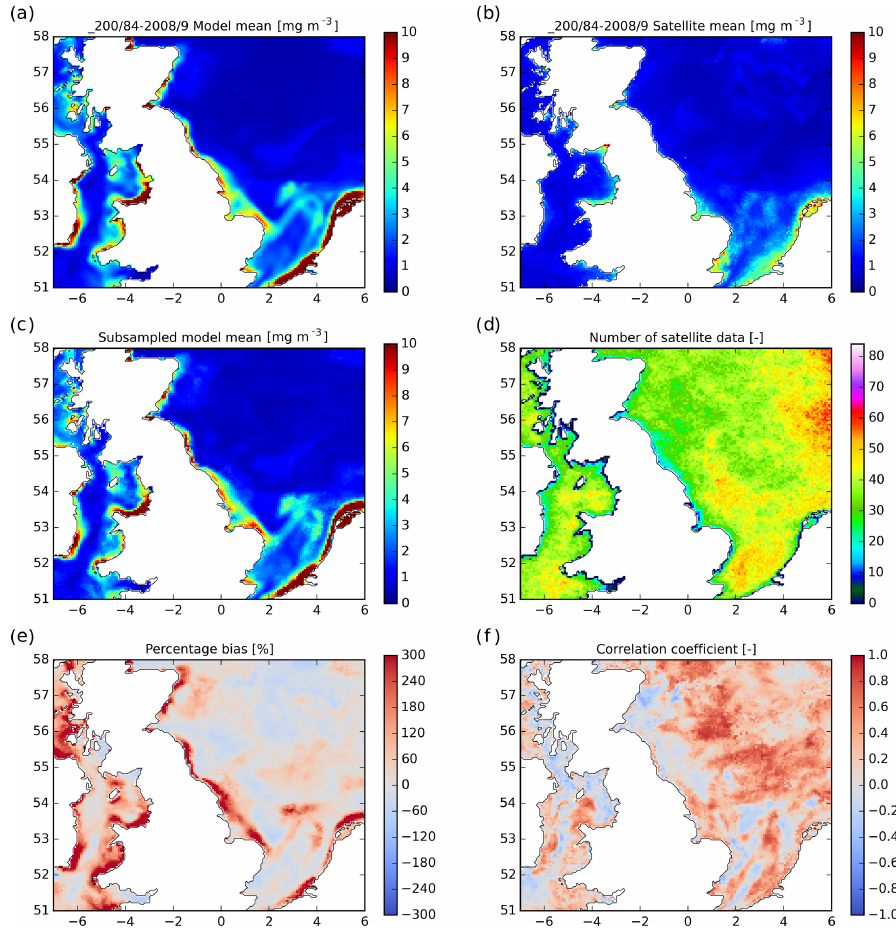
Figure 5. Comparison of summer chlorophyll- a concentrations between model and satellite (April 2008 to September 2008). (a) Model mean; (b) satellite mean; (c) model mean accounting for cloudy days; (d) number of clear days from satellite; (e) relative model bias; (f) correlation